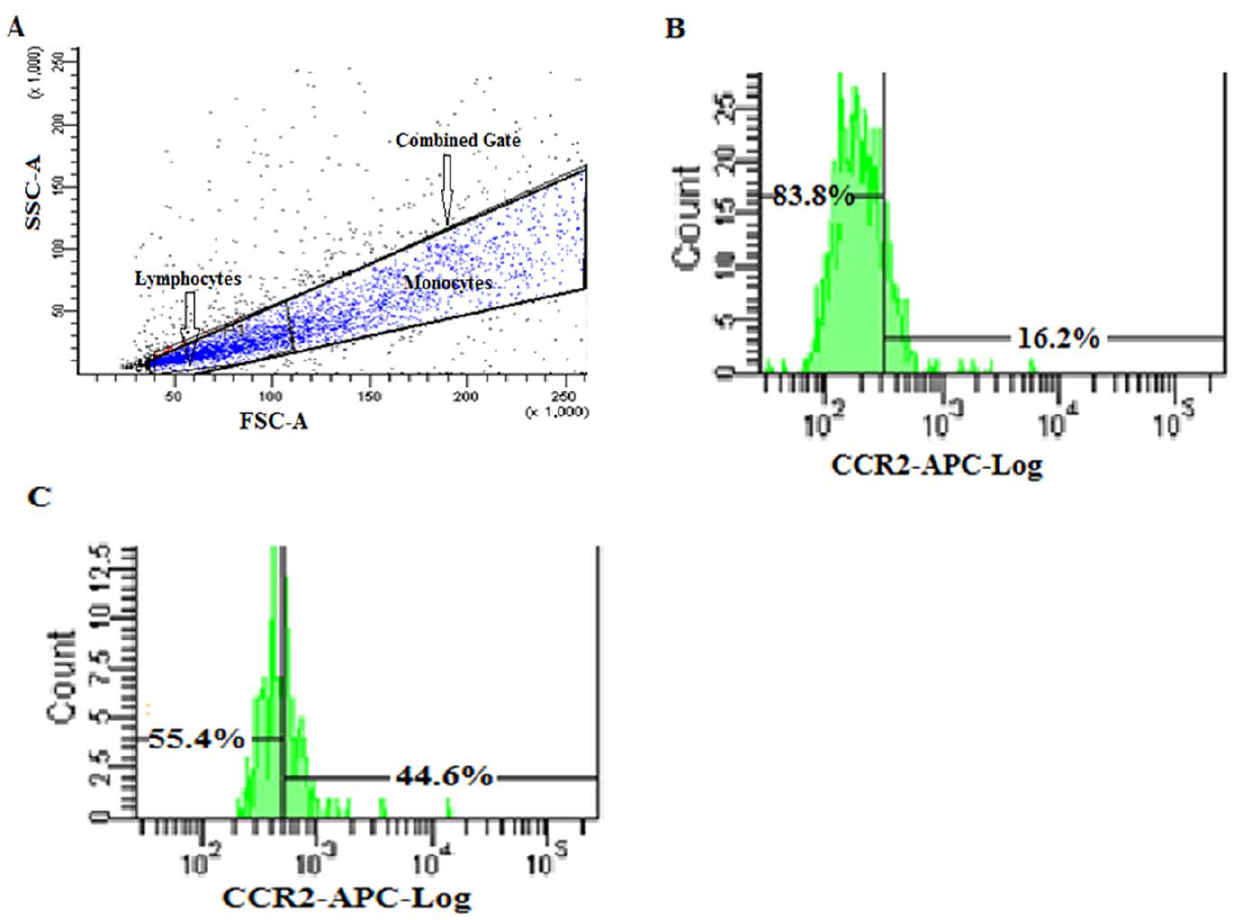
Figure 5. Percentage (%) of CCR2 + PBMCs in AMD patients and normal control subjects as measured by Flow Cytometry. (A) Dot plot showing side and forward scatter analysis of purified unlabeled PBMCs (large combined gate) from a AMD patient. PBMCs consists of two distinct populations namely lymphocytes and monocytes. Approximate lymphocytes and monocytes populations are indicated as smaller gates. Events outside the PBMCs gate represent cell debris and granulocytes. Same gating has been used for PBMCs from each AMD and normal control sample. , 10,000 events have been acquired in each experiment. X-axis represents population cell size in forward scatter (FSC) and y-axis represents population cell granularity in side scatter (SSC). (B,C) Single parameter representative histogram of flow cytometric expression pattern of CCR2 on gated PBMCs is showing decreased number of CCR2 expressing PBMCs in AMD (16.2%; B) as compared to normal control (44.6%; C). Number of cells is represented along y-axis and blue APC fluorescence along x-axis. Appropriate unlabeled PBMCs were used to set marker in histogram and